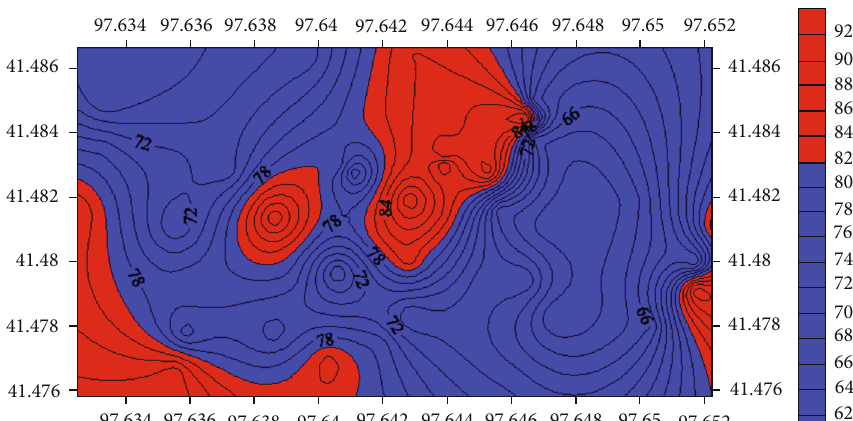
Figure 10: The contour map of theoretical F